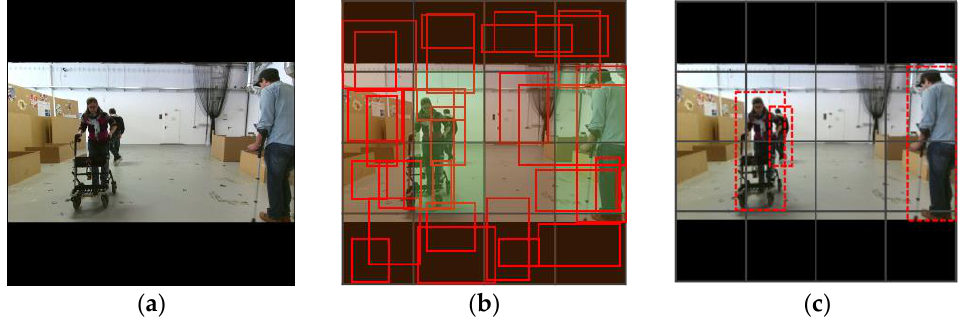
Figure 4. Example of how YOLOv1 works. ( a ) The original padded image. ( b ) The bounding box proposals and the class probabilities associated with each cell. The green cells contain a person, while the orange ones do not. ( c ) The final detections.